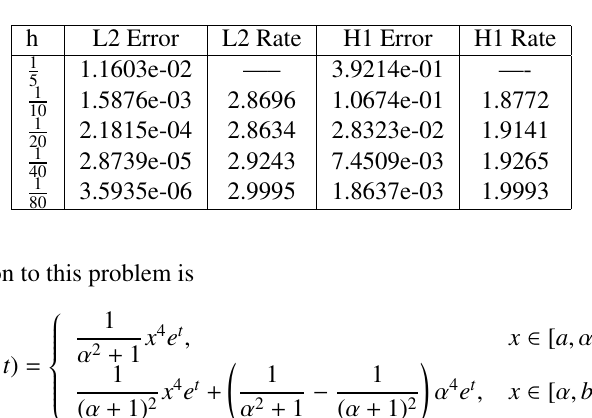
Table 4. Errors for Quadratic IFEM at final time for β + = 1 and β − = 100, ∆ t = h / 100